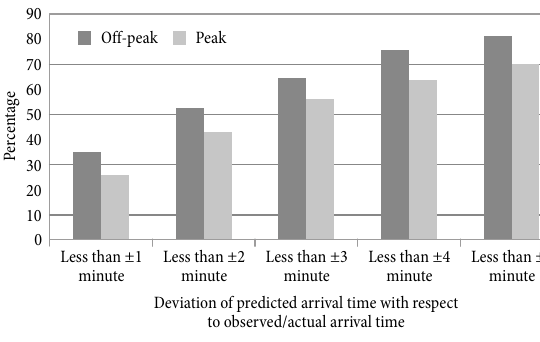
Fig. 5. Results of predicted arrival time deviation Fig. 6. Results of predicted arrival time deviation